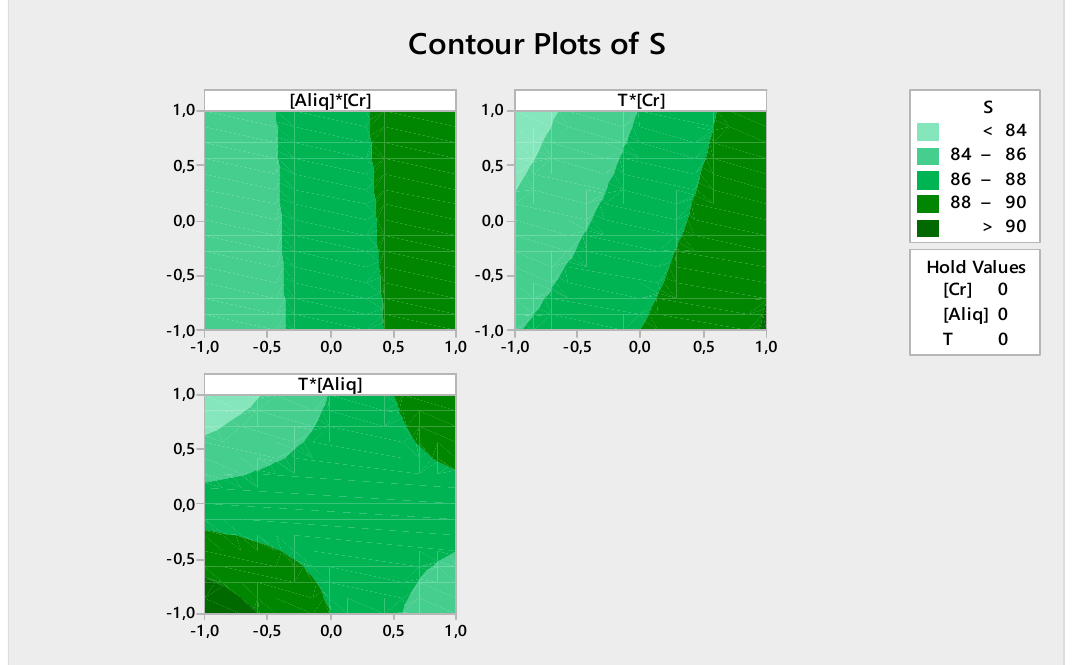
Figure 14. Contour plots of the extraction yield of Cr(VI).